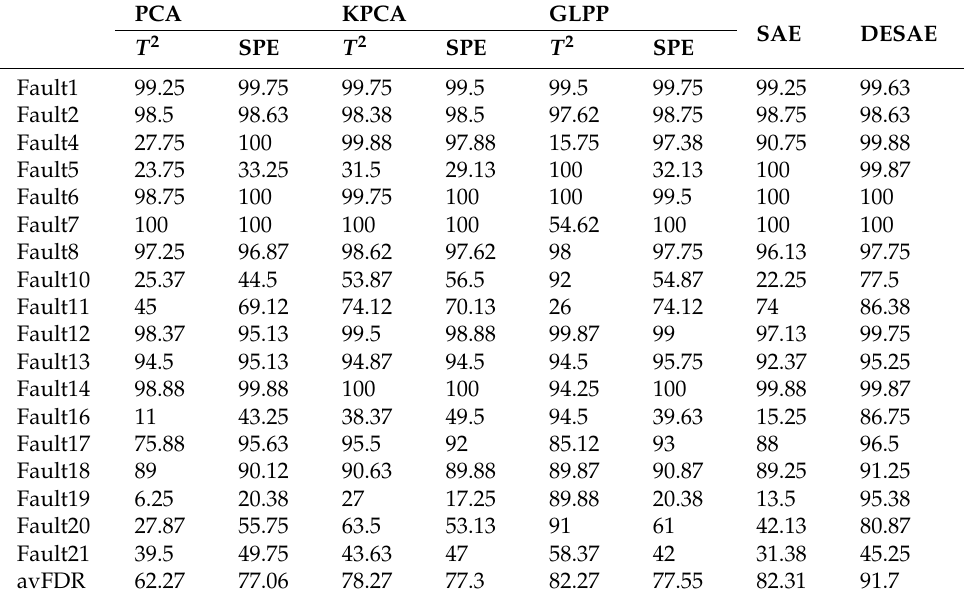
Table 2. FDR of PCA, KPCA, GLPP, SAE and DESAE on TE process.